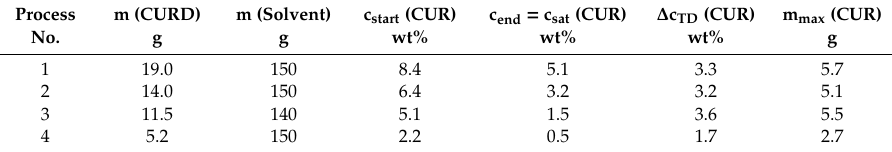
Table 5. Amount of initial substances used in the four crystallization